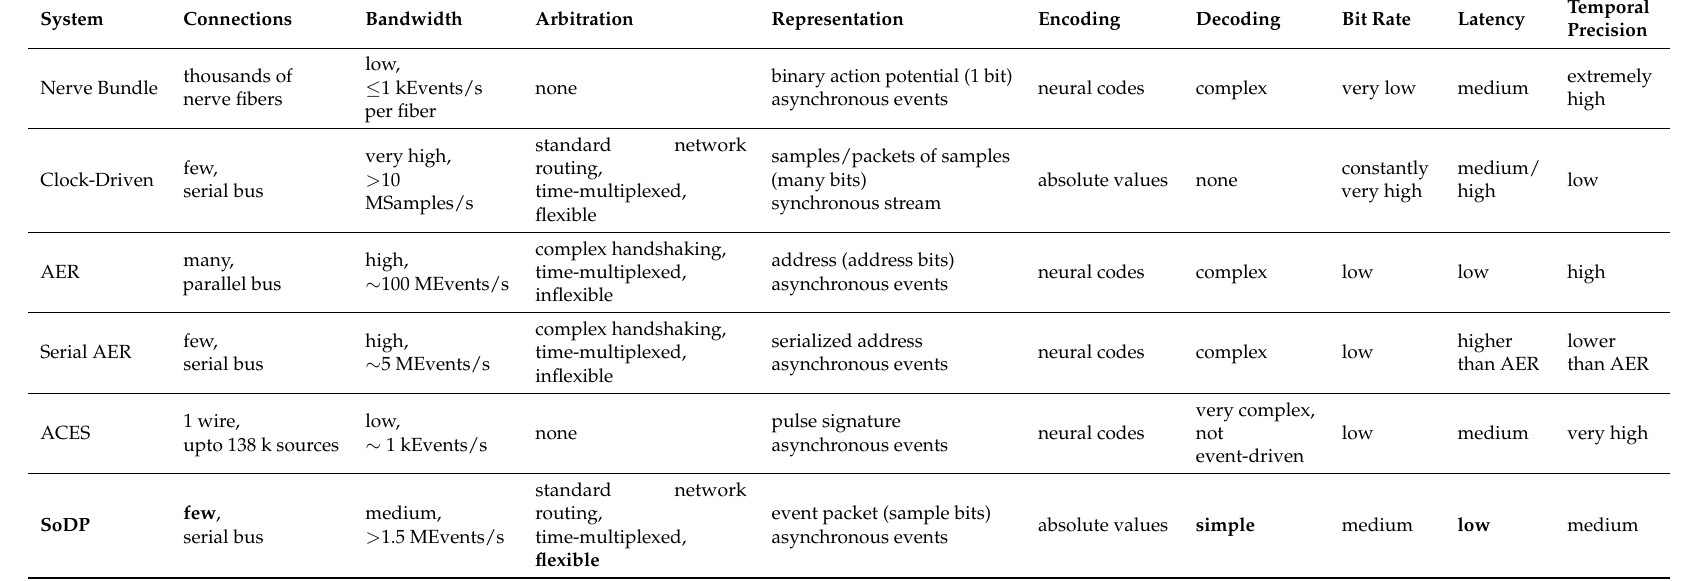
Table 1. Comparison of different information encoding, representation, and transmission